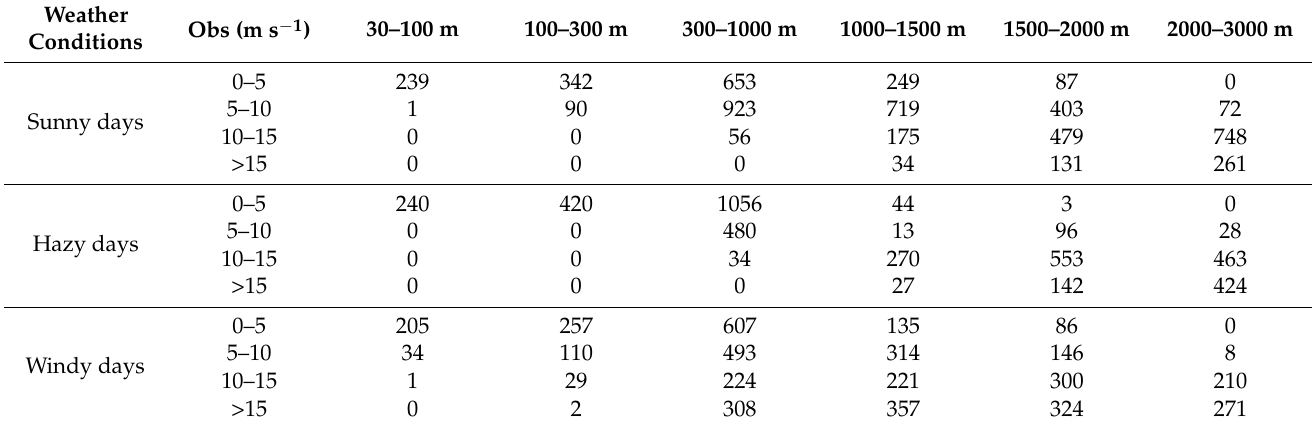
Table 2. The DWL sample size in data groups.